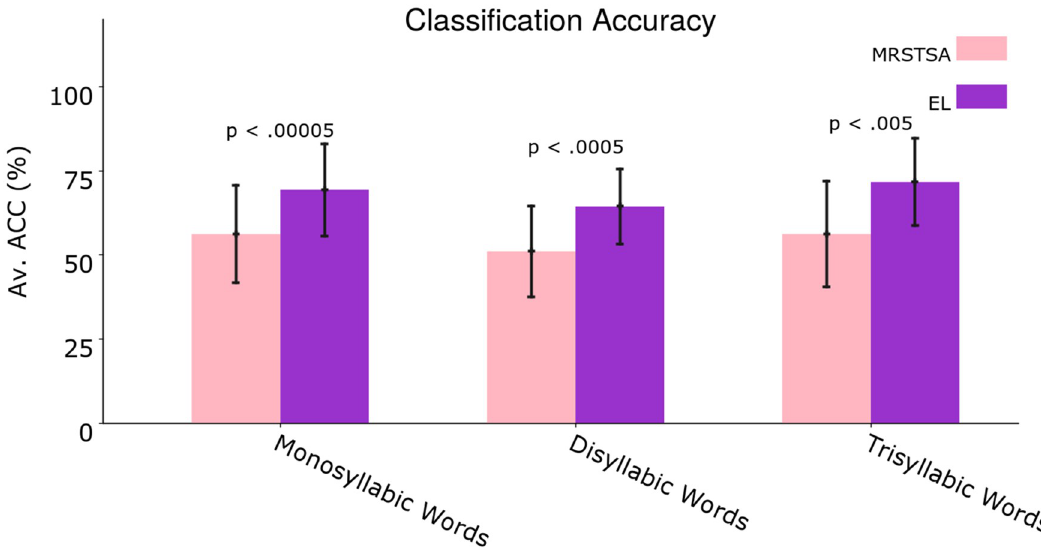
Fig 10. Average classification accuracies across all acoustic variants for mono, di and trisyllabic words. Error bars depict 95% Confidence Interval values. The p values correspond to two-tailed paired t-tests.